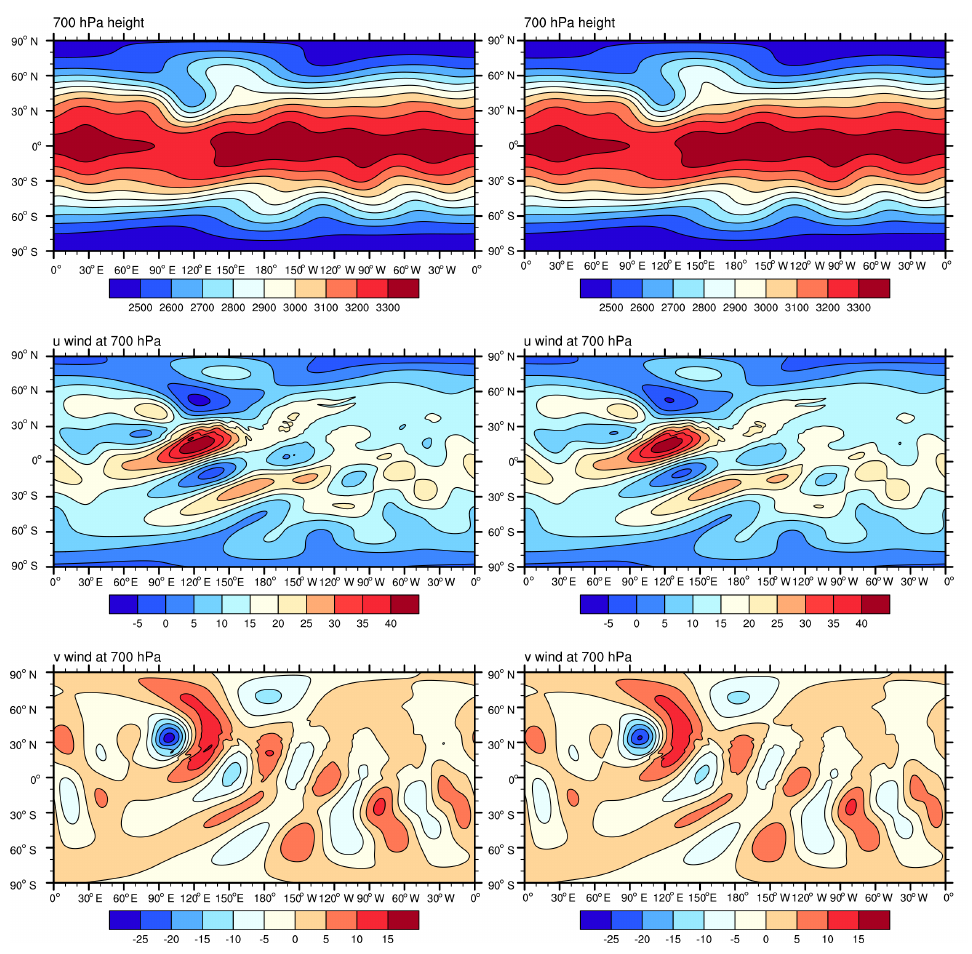
Figure 7. Day 15 u and v wind components and geopotential height at 700hPa in the mountain-induced Rossby wave test. Left column – SL-AV20 solution at 1600 × 865 with (cid:49)t = 300s. Right column – the same as the left column, but with (cid:49)t =